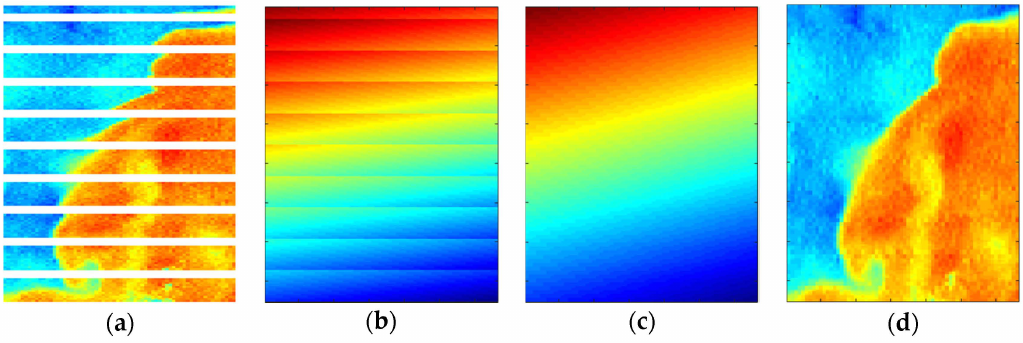
Figure 4. ( a ) Original VIIRS SST with bow-tie distortions and deletions (note the jumps and repeats along the SST thermal fronts, and that onboard deleted pixels are shown in white); ( b ) original latitudes; ( c ) unfolded latitudes; ( d ) corresponding resampled